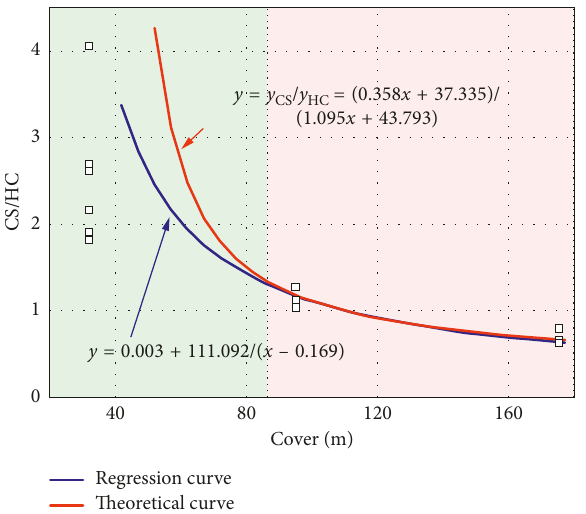
Figure 11: Linear regression between HC and cover depth at 12.26m